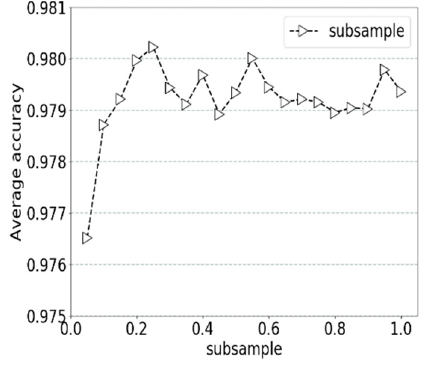
Figure 8. Subsample and accuracy.